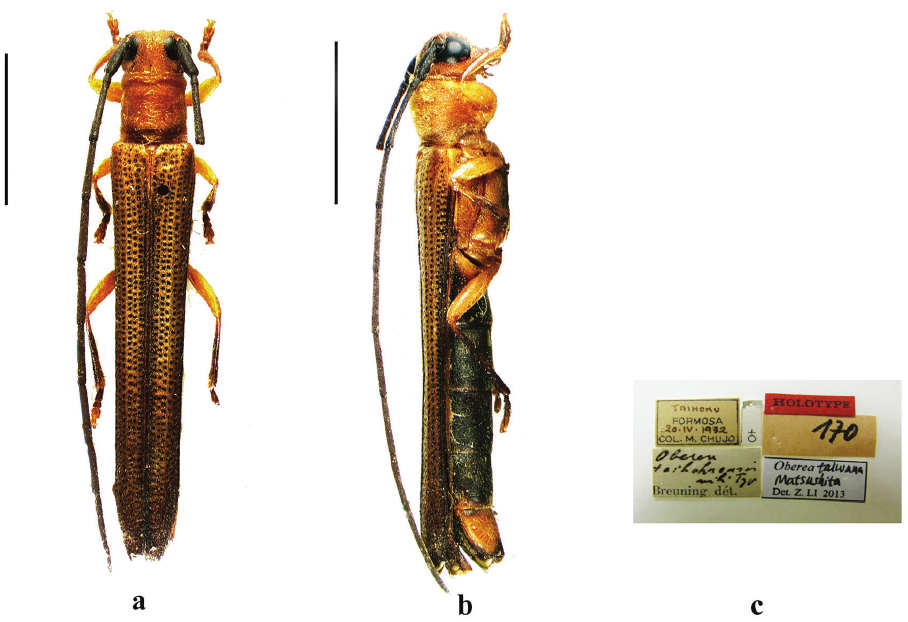
Figure 6. Habitus of O. taihokuensis Breuning, 1962, holotype, female, from Taiwan, a dorsal view b lateral view, c label (not to scale). Scale bar 5.0